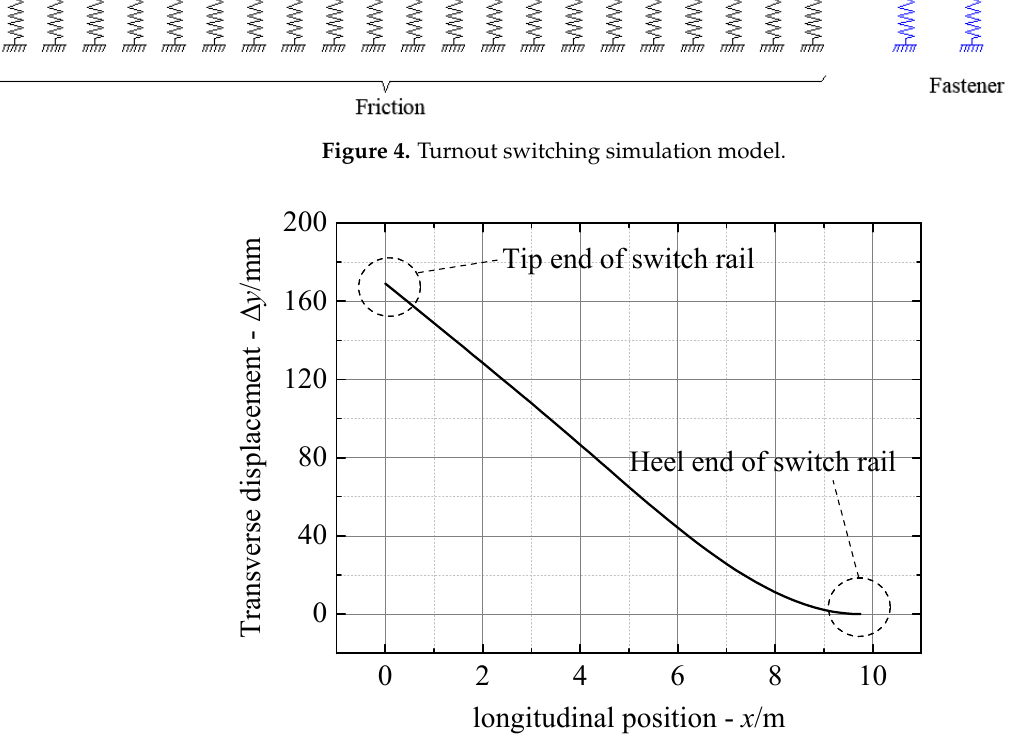
Figure 5. Transverse displacement distribution curve of switch rail separated from stock rail. Based on the design scheme, the plane alignment of the switch rail very close to the stock rail is obtained. The same discretization method is employed on the switch rail to obtain the longitudinal position coordinates of x 1 , x 2 , x 3 , ..., x n + 1 and the corresponding transverse position coordinates y m ( x 1 ) , y m ( x 2 ) , y m ( x 3 ) , ..., y m ( x n + 1 ) . The transverse posi- tion coordinates y m ( x i ) of the switch rail in contact with the stock rail and the displacement distance ∆ y ( x i ) after the separation from the stock rail are calculated by adding data